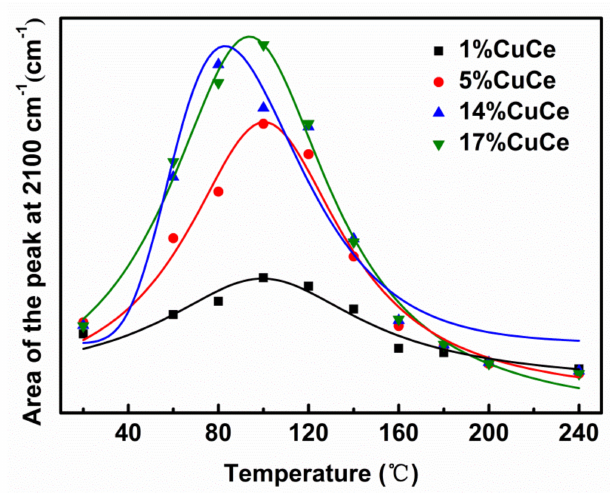
Figure A5. Integrated area of the Cu + -CO band at 2100 cm − 1 as a function of